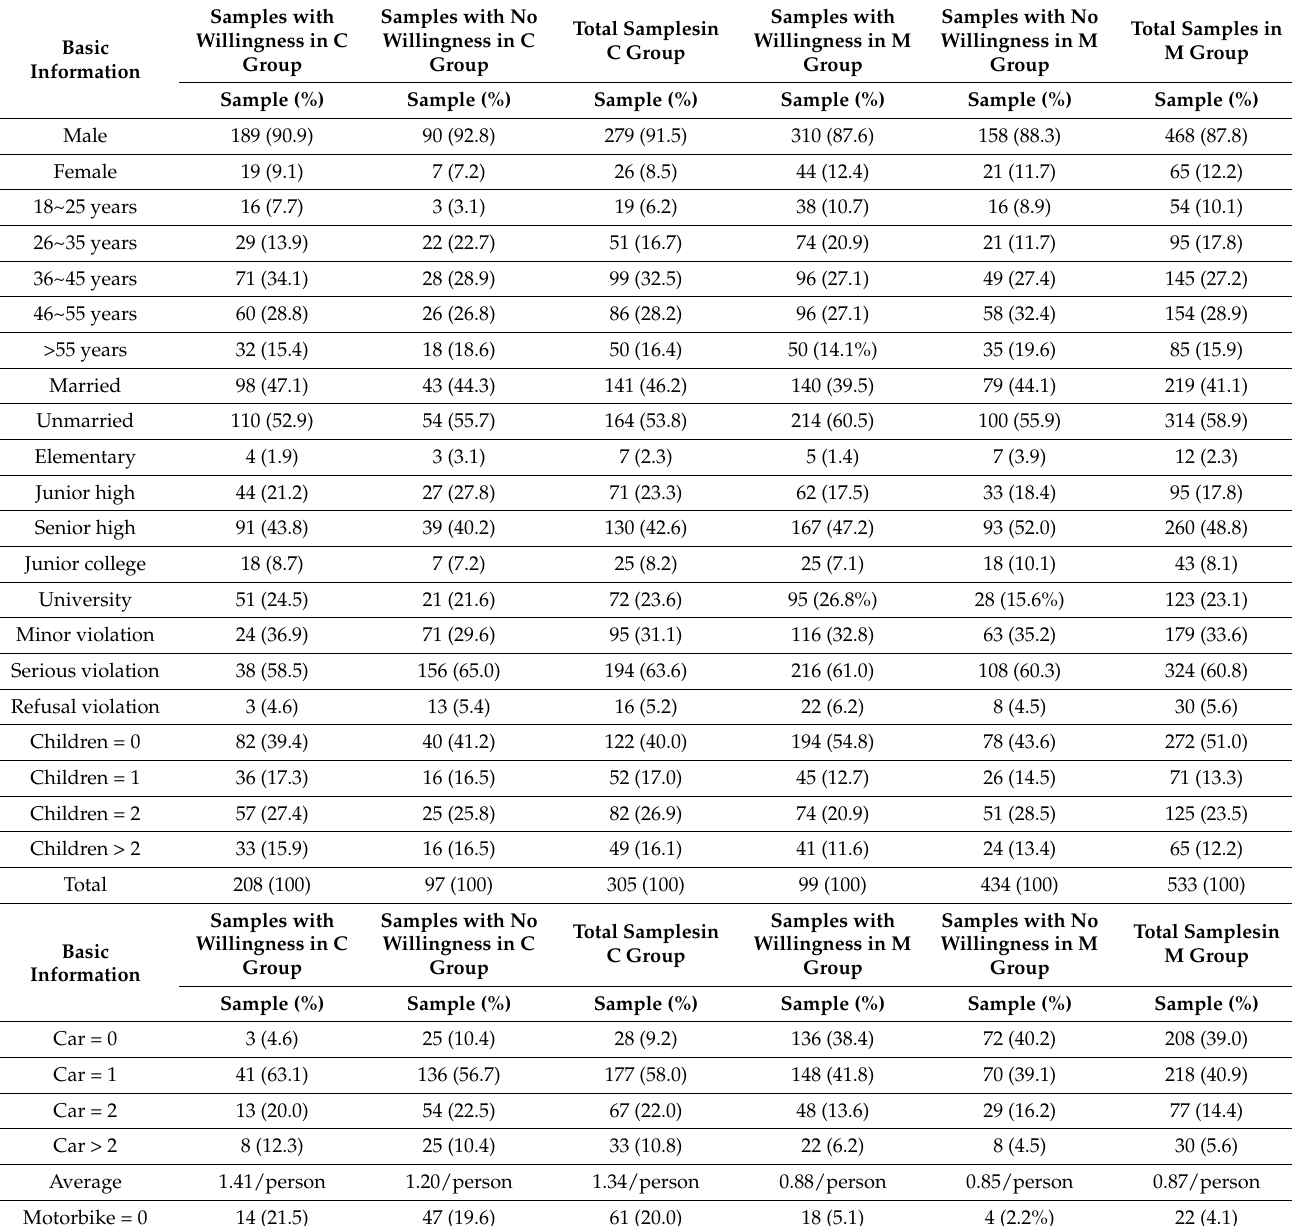
Table 2. Analysis of drunk car/motorbike drivers’ willingness to pay for alcohol interlock (social-economic characteristics).